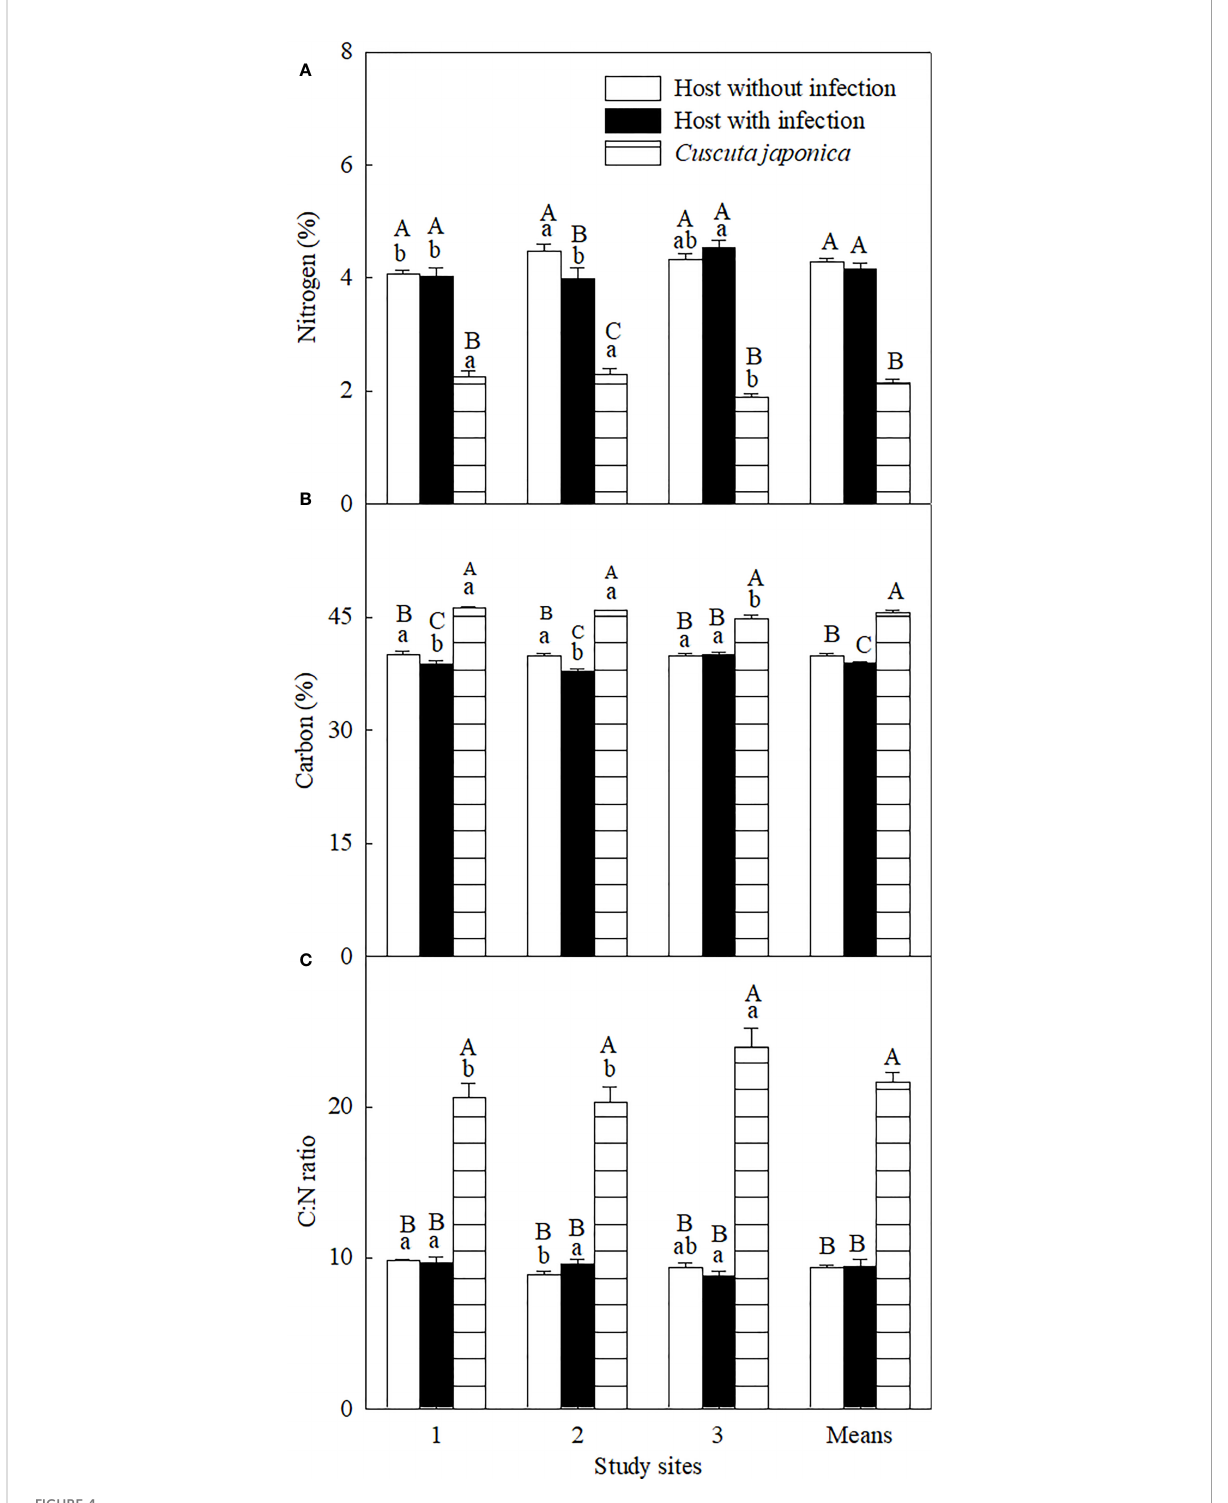
FIGURE 4 Concentrations of leaf nitrogen (A) and carbon (B) , and C:N ratio (C) of Ambrosia tri fi da uninfected (open bars) and infected (closed bars) by Cuscuta japonica , and the stems of C. japonica (horizontal-striped bars) at different sites. Means + 1 SE ( n = 6). Different lowercase letters indicate signi fi cant differences among sites for uninfected and infected host plants and the parasite, respectively; different uppercase letters indicate signi fi cant differences among uninfected and infected host plants and the parasite at the same site ( P < 0.05; one-way